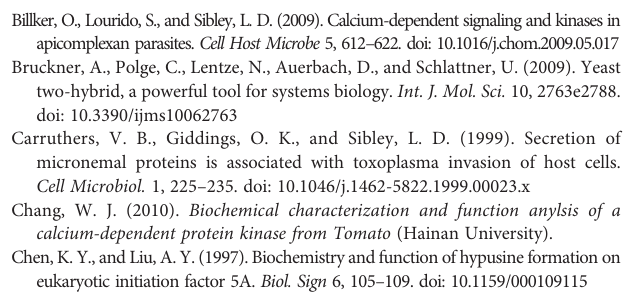
SUPPLEMENTARY FIGURE 1 | SDS-PAGE analysis of pulled-down and co- immunoprecipitated proteins. M: Protein marker; 1: Positive sample of His pull- down; 2: Negative control of His pull-down; 3: Positive sample of co-IP; 4: Negative control of co-IP. SUPPLEMENTARY FIGURE 2 | Bioinformatics analysis of Et eIF-5A cDNA and deduced amino acid sequence. Underlined, amidation site; dotted underlined, casein kinase II phosphorylation site; double underlined, N-myristoylation site; yellow background, protein kinase C phosphorylation site; italics, translation initiation factor 5A (eIF5A); wavy underlined, eIF5A hypusine signature; gray background, bacterial Ig-like domain 1 domain pro fi le; boxed, KOW motif; red font, eIF5A hypusine oligonucleotide/oligosaccharide-binding fold motif; asterisk: stop codon. SUPPLEMENTARY FIGURE 3 | Co-localization of Et eIF-5A and Et Ub in Eimeria tenella . A.B: immature schizont (iSC) at 48 h p.i. SUPPLEMENTARY FIGURE 4 | Negative control of localization by indirect immuno fl uorescence. A: Healthy rabbit IgG against Spz by UV; B: Healthy rabbit IgG against Mrz by UV; C: Healthy rabbit IgG against Spz invasion for 2h by UV; D: Healthy rabbit IgG against Spz invasion for 24h by UV; E: Healthy rabbit IgG against Spz in bright; F: Healthy rabbit IgG against Mrz in bright; F: Healthy rabbit IgG against Spz invasion for 2h in bright; H: Healthy rabbit IgG against Spz invasion for 24h in bright. SUPPLEMENTARY DATA SHEET 1 | Shotgun analysis of mass spectrum screening